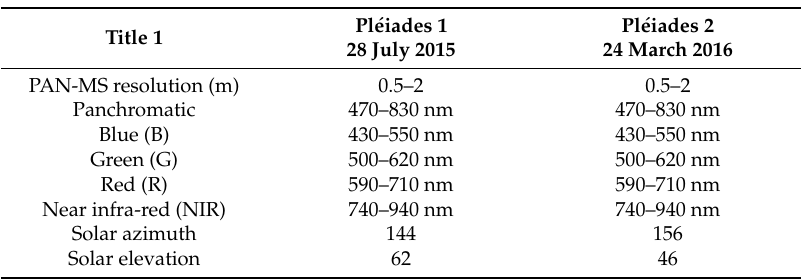
Table 1. Details of Pl é iades imagery used for the urban tree species classification.